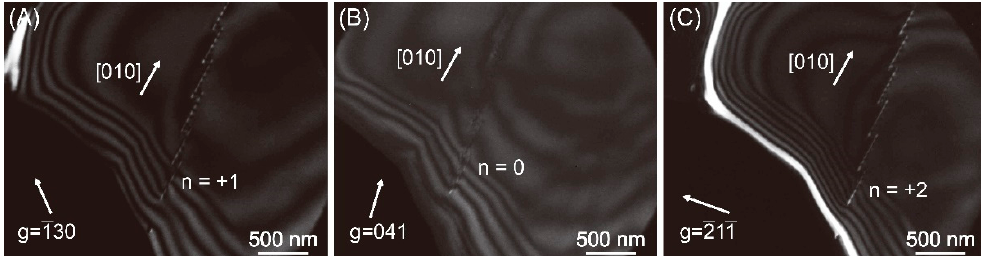
Figure 8. Weak-beam dark-field images showing subgrain boundary of olivine in sample 448. The diffraction vectors for each image are noted as g . The white arrow and n value indicate the number of the terminating thickness fringes for each image. ( A – C ) WBDF images of the same location with three different diffraction vectors: g = 1´ 30 in ( A ), g = 041 in ( B ), and g = 2´ 1 1´ , in ( C ).